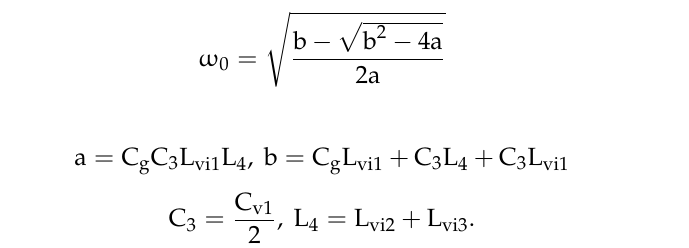
Figure 3. The equivalent circuit of the proposed resonator.